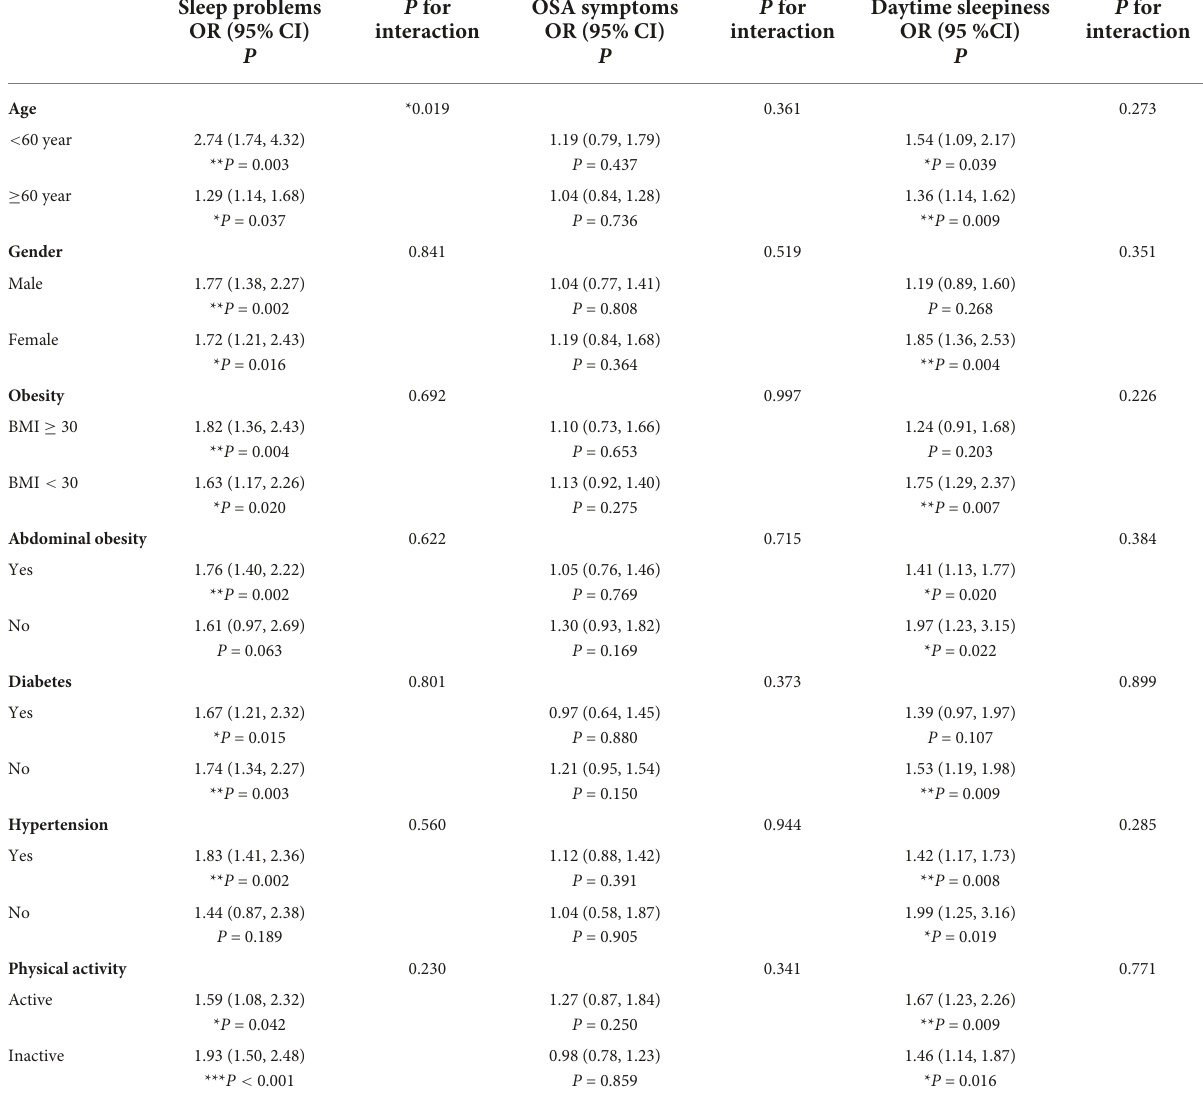
TABLE 5 Subgroup analysis of the associations of sleep-related disorders with total